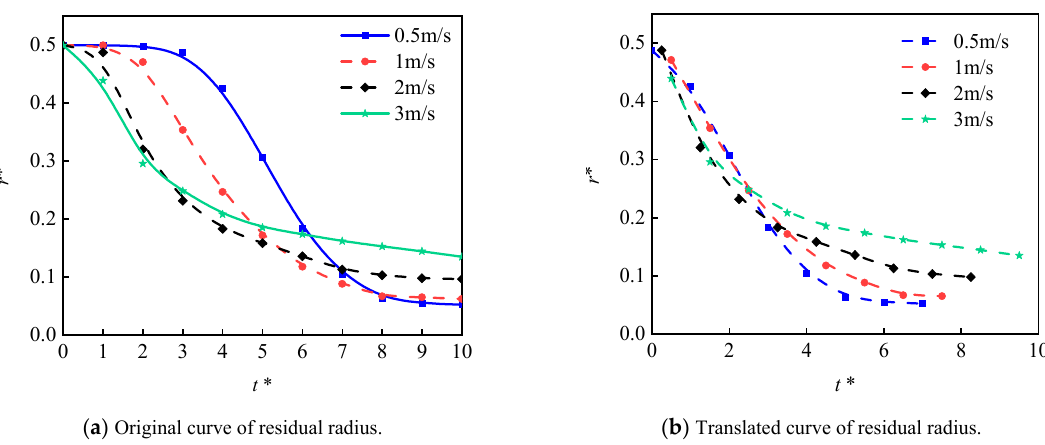
Figure 23. Droplet vaporization on the smooth surface with the various impinging velocities.